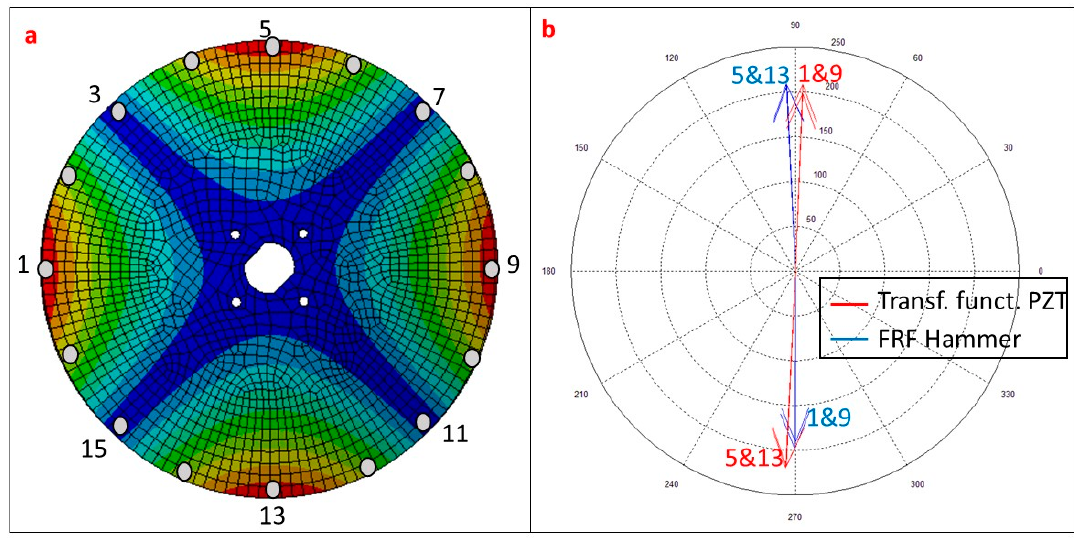
Figure 8. ( a ) First Mode Shape of the analyzed structure with measured points; ( b ) Representation of H ( j ω r ) for the points with maximal deformation (Hammer and